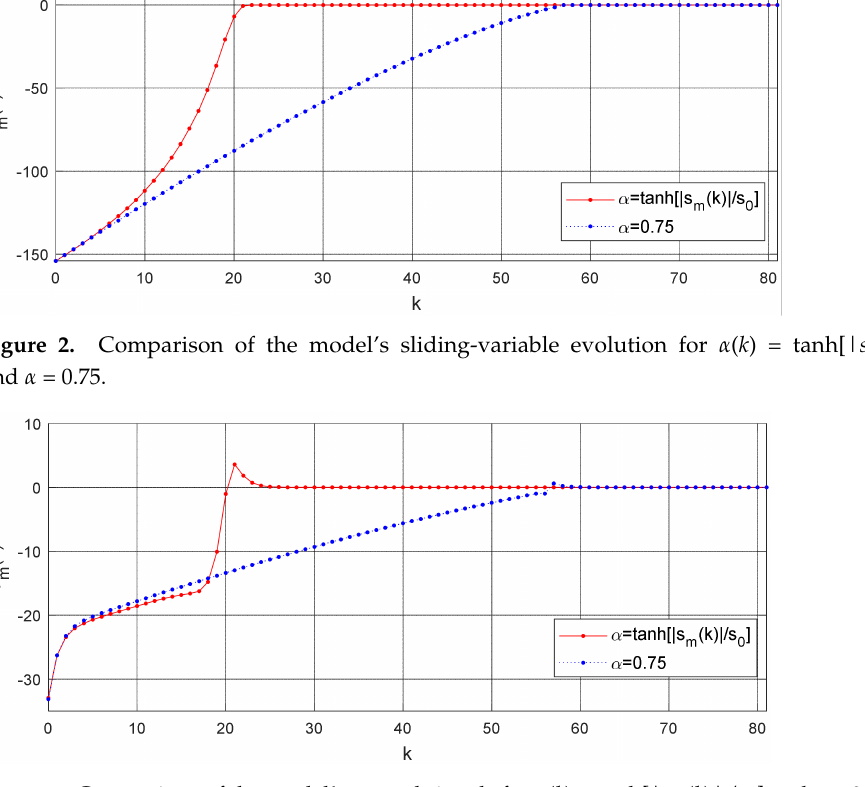
Figure 3. Comparison of the model’s control signals for α ( k ) = tanh[| s m ( k )|/ s 0 ] and α =